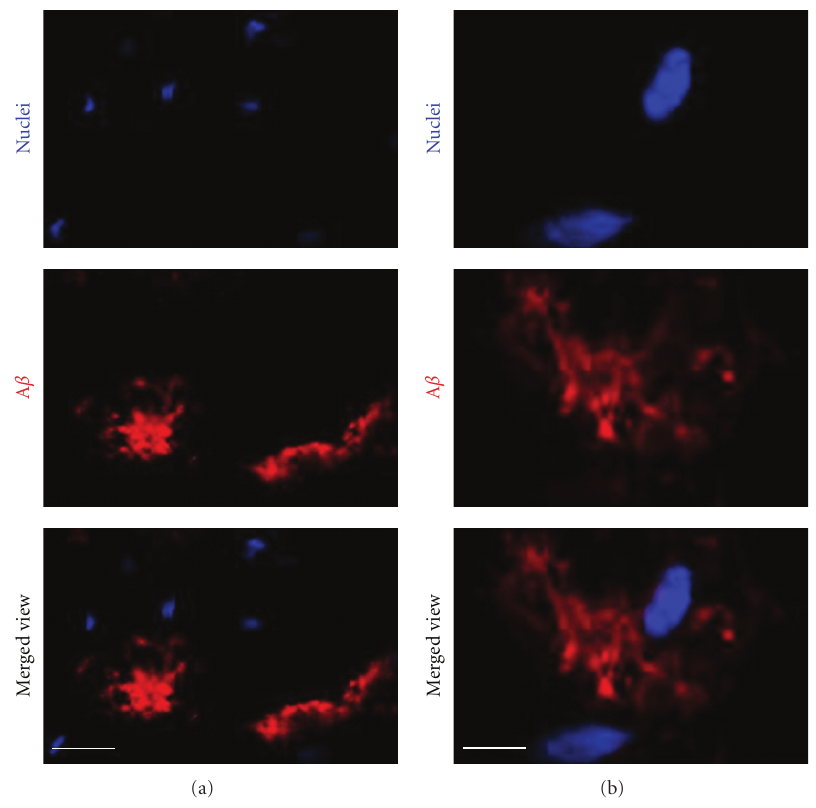
Figure 1: Immunohistochemical localization of A β s in the cortex of double transgenic mice coexpressing mouse/human chimeric APP with the Swedish mutation and human presenilin-1 with deletion of exon 9. The coronal brain sections are 12 μ m in thickness. Nuclei (blue) and A β (red) were stained with Hoechst 33258 and antihuman A β antibody, respectively. (a) low-magnification view; (b) high-magnification view. Bar = 20 μ m in (a); 5 μ m in (b). (Reproduced from [85] with